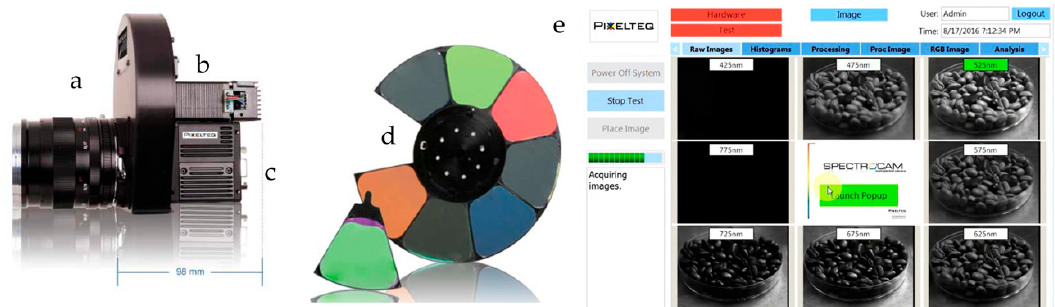
Figure 1. Pixelteq camera (Ocean Insight, Duiven, The Netherlands) consisting of: ( a ) an F-mount objective, ( b ) the filter wheel casing, ( c ) a CCD (charge-coupled device) camera, and ( d ) the filter wheel, which contains 8 replaceable filters. The camera was attached to the camera port of the fundus camera. ( e ) User interface software of the Pixelteq camera (Ocean Insight).